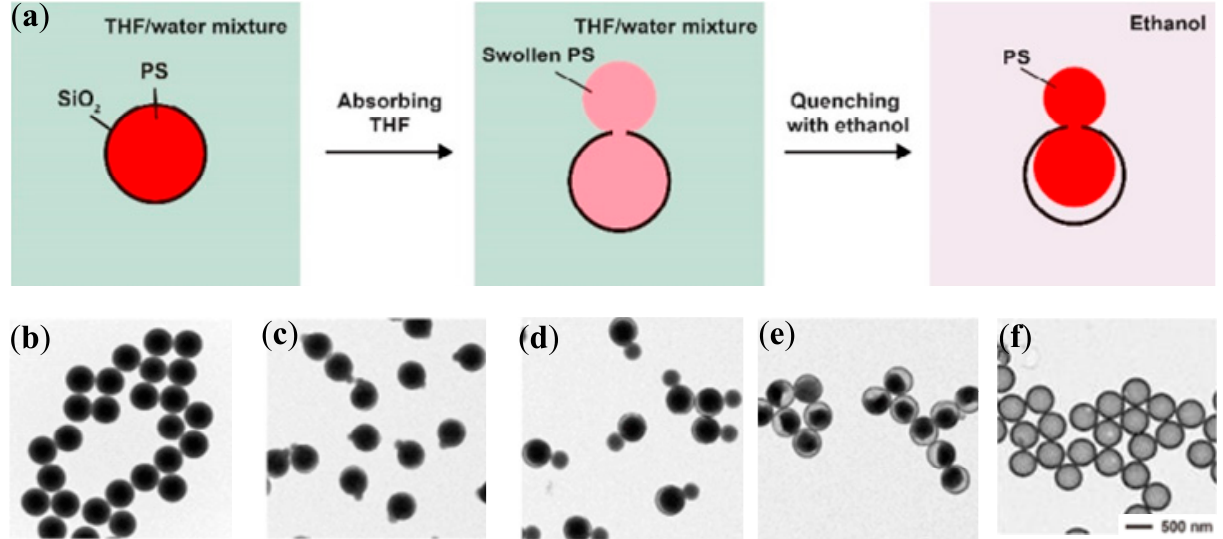
Figure 6. ( a ) The fabrication steps of nanobottle. ( b ) TEM image of polystyrene particles coated with SiO 2 . ( c – e ) TEM images of Janus structure obtained through swelling with 0, 20, 30 and 50% tetrahydrofuran/water mixture. ( f ) SiO 2 nanobottles obtained by dissolution of polystyrene particles with pure tetrahydrofuran. The scale bar is 500 nm. Reprinted with permission from Ref. [73]. Copyright 2021, copyright Wiley-VCH GmbH.